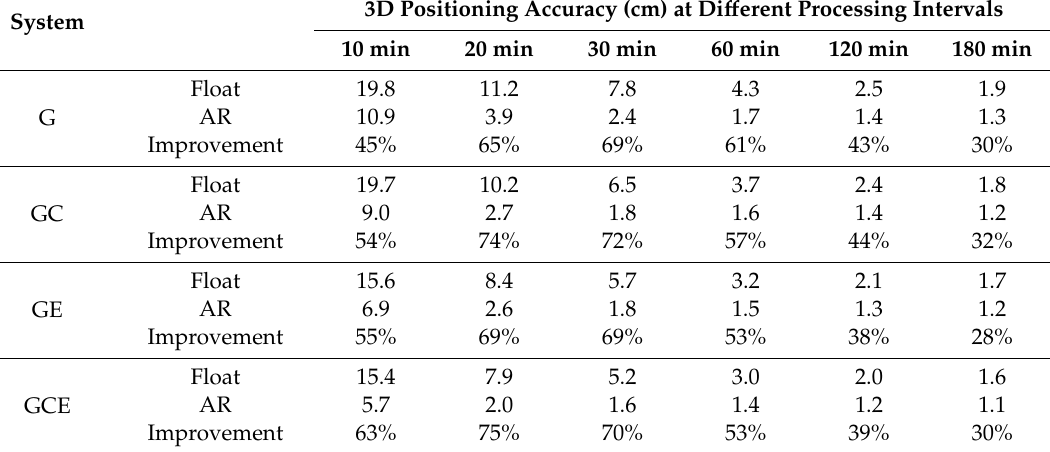
Table 2. Positioning accuracy for GPS, BDS-2, and Galileo.